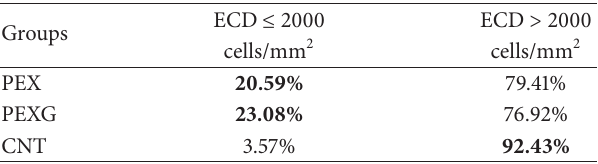
Table 5: The risk of corneal endothelium decompensation of individual study